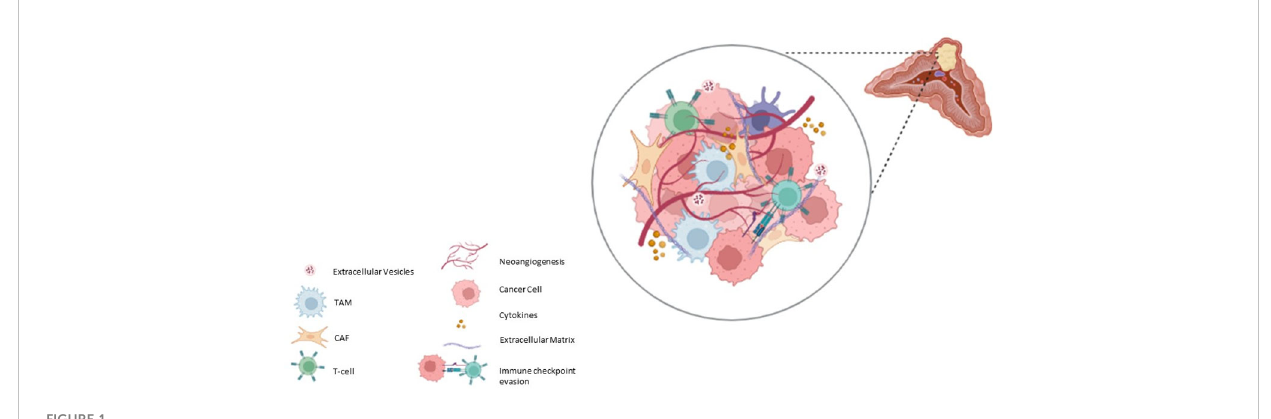
FIGURE 1 Schematic representation of Pheo/PGL